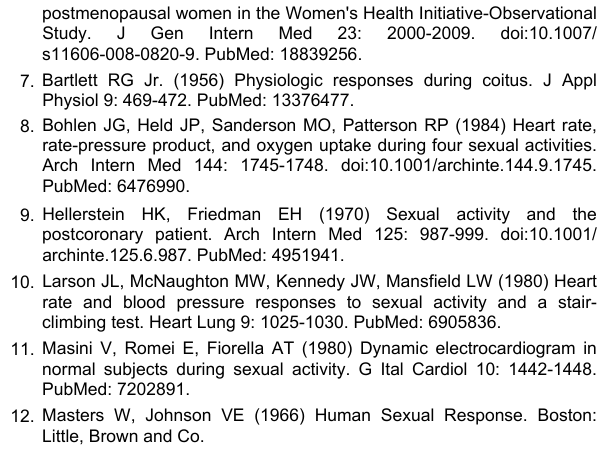
Comparison of Effort Between Sexual Activity and